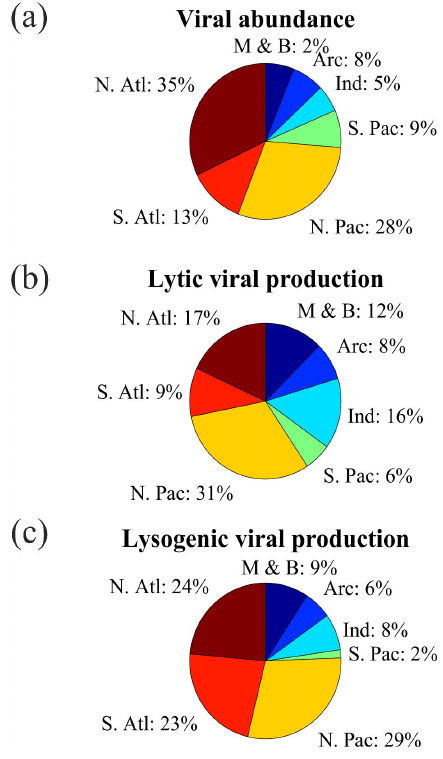
Figure 2. The fraction of (a) viral abundance, (b) lytic viral pro- duction and (c) lysogenic viral production data points in different oceans (N. Atl: North Atlantic, S. Atl: South Atlantic, N. Pac: North Pacific, S. Pac: South Pacific, Ind: Indian Ocean, Arc: Arctic Ocean, M & B: Mediterranean Sea and Baltic Sea).